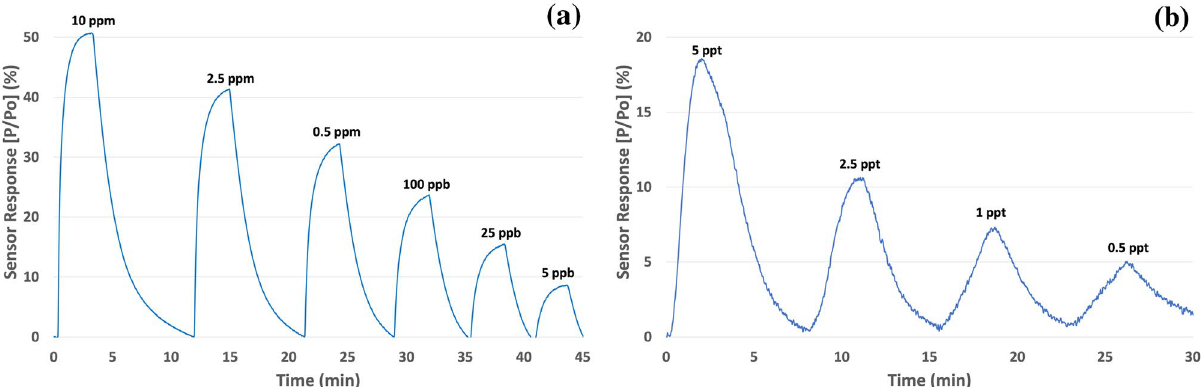
Figure 9. Response of a free-standing sensor to concentrations of TATP ranging from 5 ppb to 10 ppm ( a ) and concentrations of RDX ranging from 0.5 to 5 ppt ( b